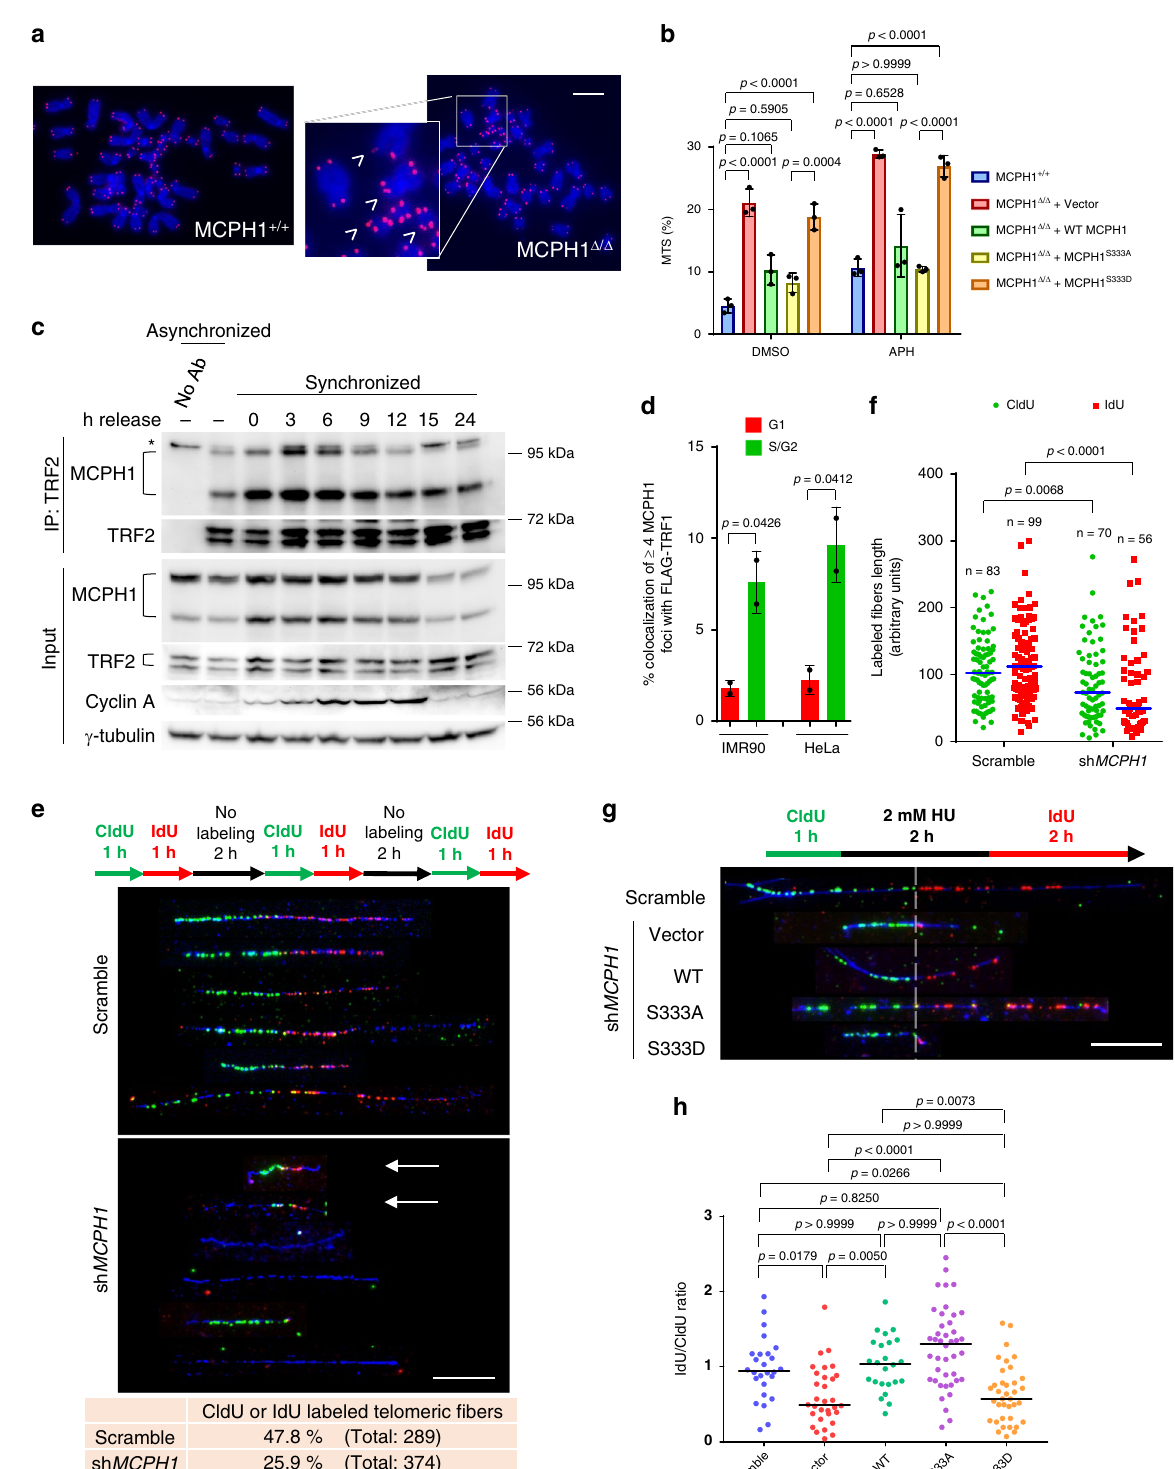
dramatically reduced in comparison to WT MCPH1 and MCPH1 S333A (Supplementary Fig. 7m, n). Together, these results suggest that MCPH1 localizes at stalled replication forks at telomeres in a TRF2-dependent manner, counteracting telomeric replication stress to promote replication fork progression through telomeric